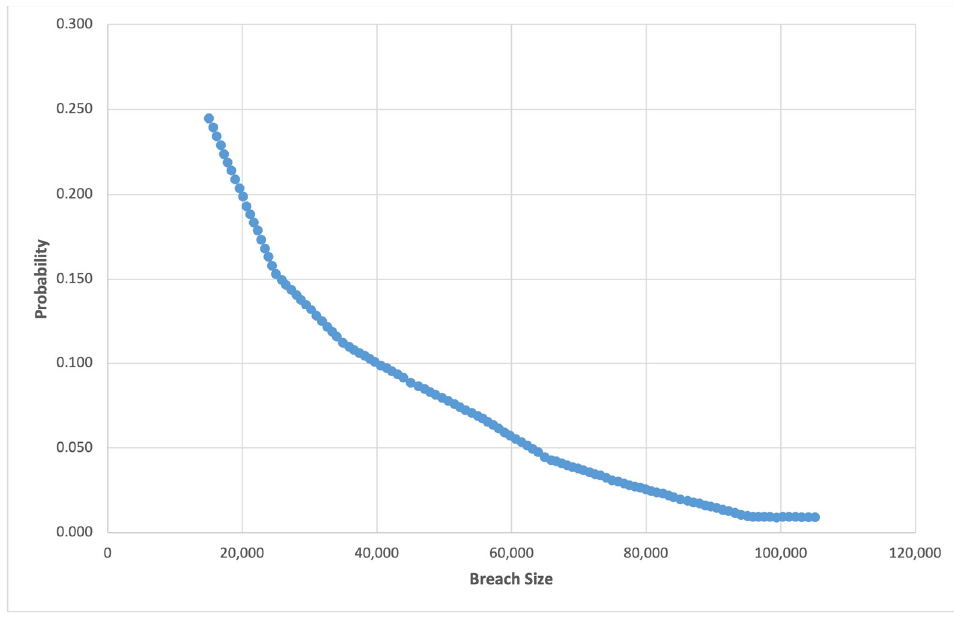
Figure 5. Data breach probability based on the breach size (Ponemon data 2015) [36].